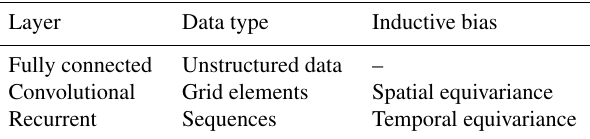
Table 1. Inductive biases and preferred types of data for different neural network layers (adapted from Battaglia et al.,